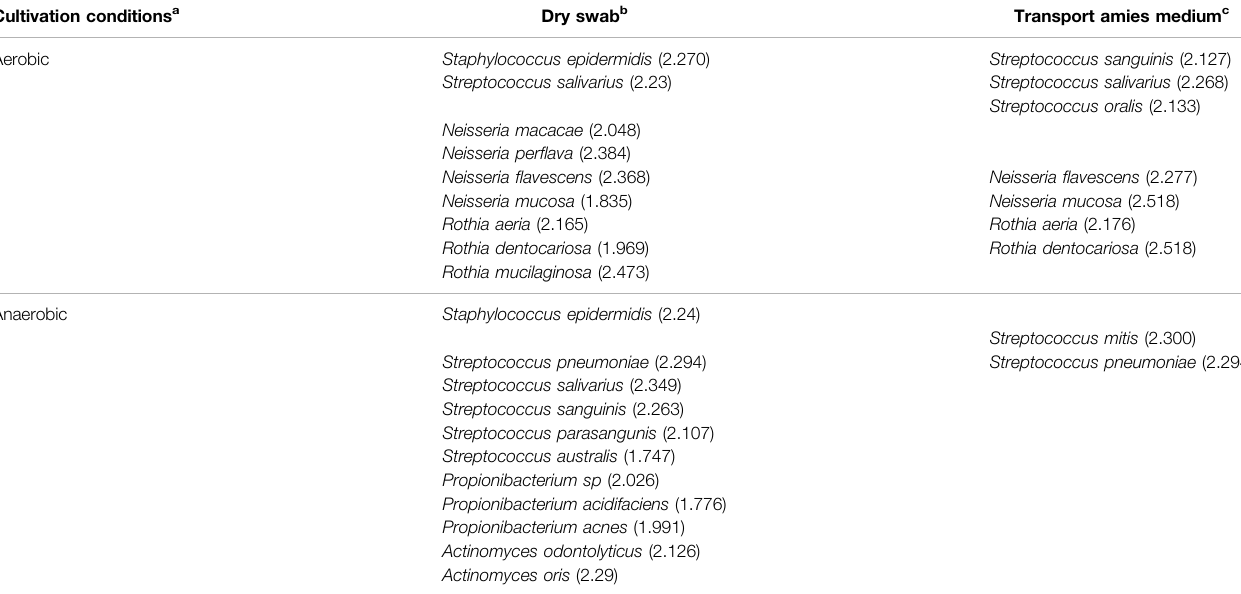
TABLE 1 | MALDI-TOF-MS Biotyper identi fi cation of microorganisms. Cultivation conditions